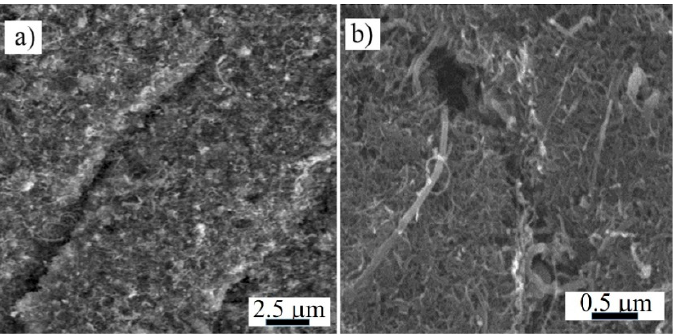
Figure 6. SEM micrographs of the surface of the entangled MWCNT network structure with cracks transverse to the direction of the extension of the nanopaper after its compression by 4 MPa. ( a ) A detailed view of the crack ending. ( b ) A view of nanotubes bridging a crack.